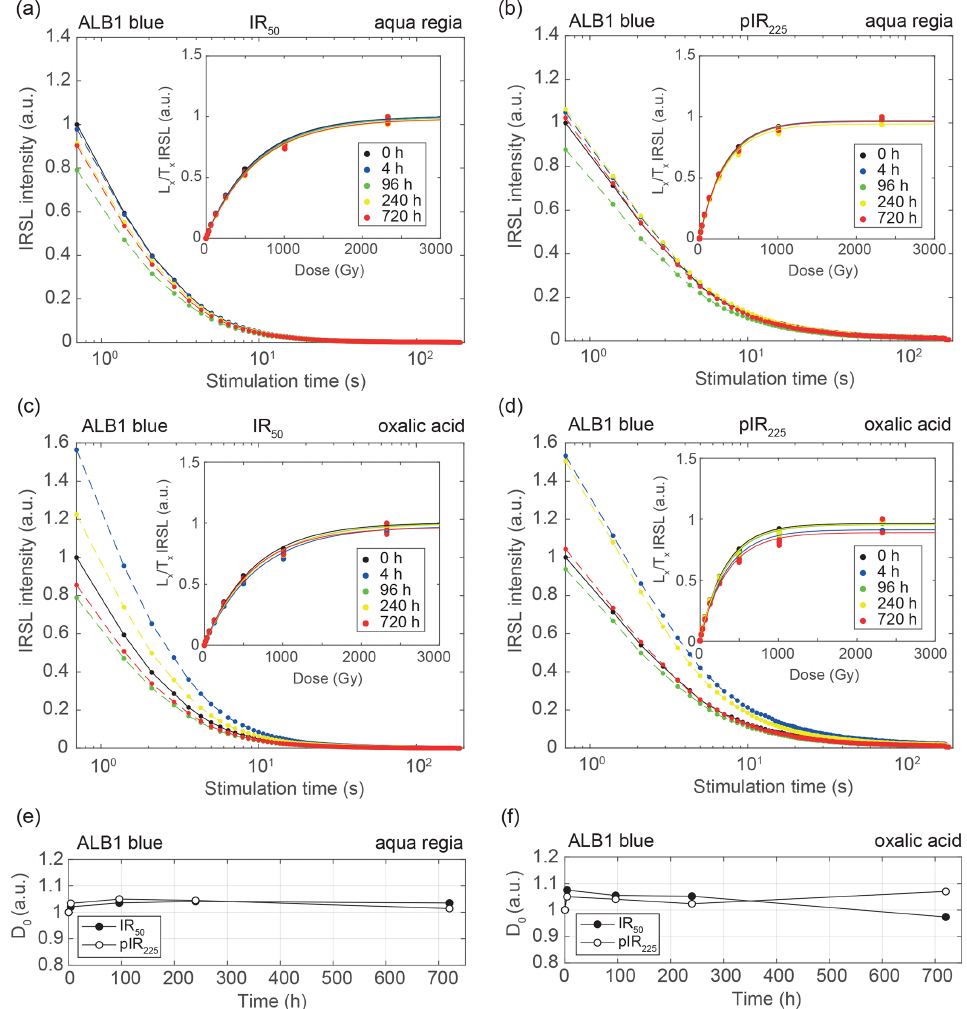
Figure 6. Exemplary pIR-IRSL signal decay, dose response (inset) (a–d) , and characteristic saturation dose ( D 0 ; e–f ) data of sample ALB1 measured of the blue emission before (0h) and after aqua regia and oxalic acid treatment (4–720h). IRSL signals are presented as the mean of three multi-grain aliquots and normalised to the initial (untreated, 0h) IR 50 and pIR 225 signals. The single saturating exponential function was used to fit the regenerative dose points in the dose response curves. Fitting was performed through three measured aliquots and normalised to the highest IRSL intensity. D 0 values are normalised to the initial D 0 values of the IR 50 and pIR 225 signals.